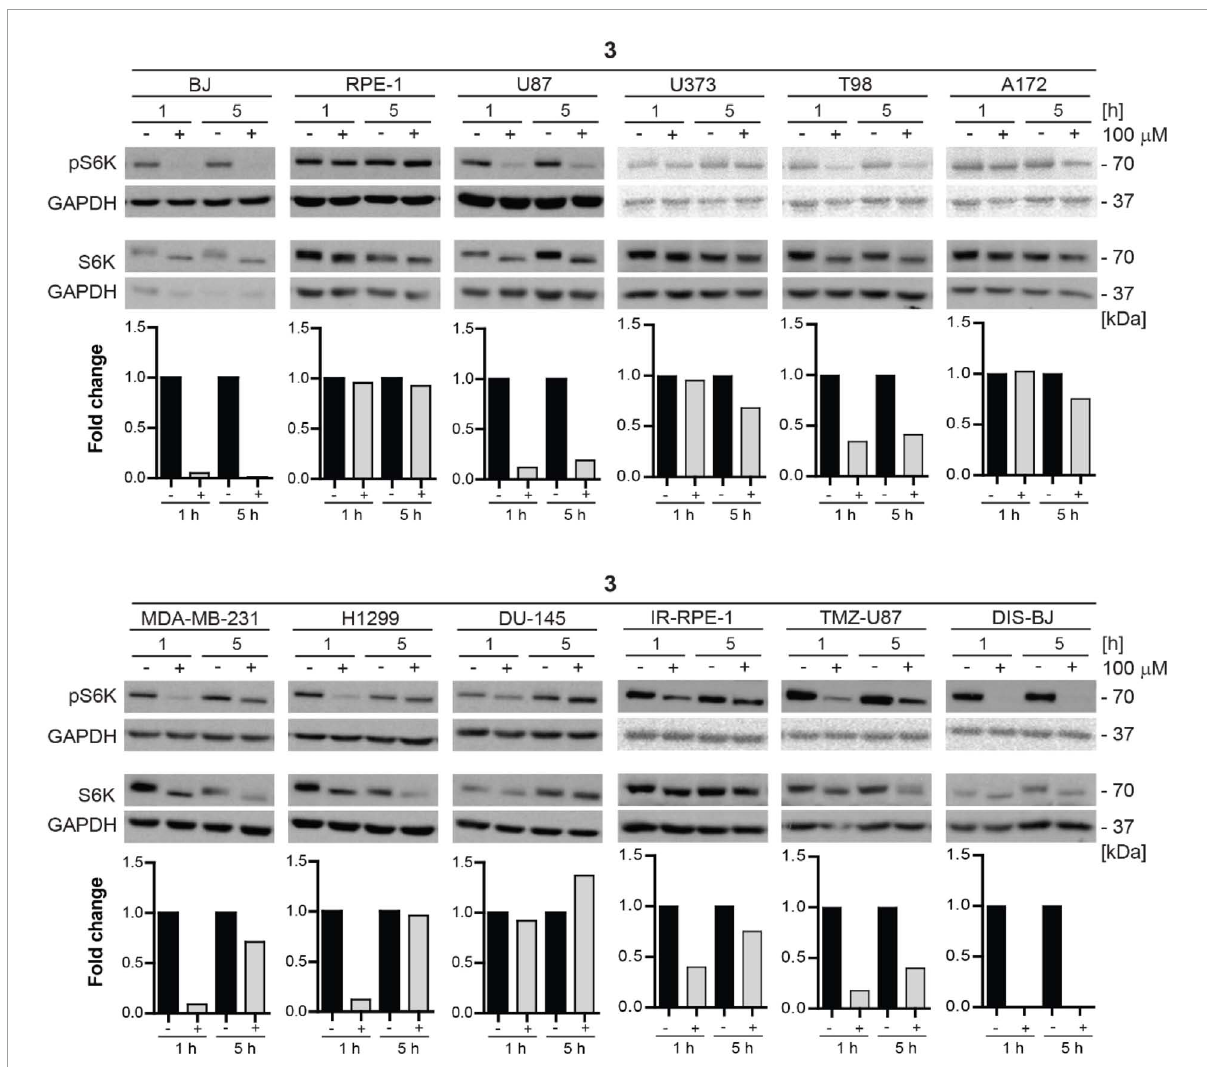
FIGURE10 Inhibitory effect of new compound 3 on mTORC1 kinase and its substrate S6 kinase in various cell lines. Human dermal fibroblasts BJ, immortalized retinal pigment epithelium RPE-1, glioblastoma U87, U373, T98, A172, breast adenocarcinoma MDA-MB-231, lung cancer H1299, prostate cancer DU-145 cells, ionizing radiation (IR)-induced RPE-1, docetaxel (DTX)-induced BJ, and temozolomide (TMZ)-induced U87 were exposed to compound 3 (100 µ M) for 1- and 5-h-long exposure. Whole-cell lysates were subjected to SDS-PAGE/immunoblotting analysis and probed for phospho-p70 S6K (Thr389) and total p70 S6K. GAPDH was used as a loading control. Quantitative analysis of immunoblots was done by Image J 1.48v program with GAPDH as the internal